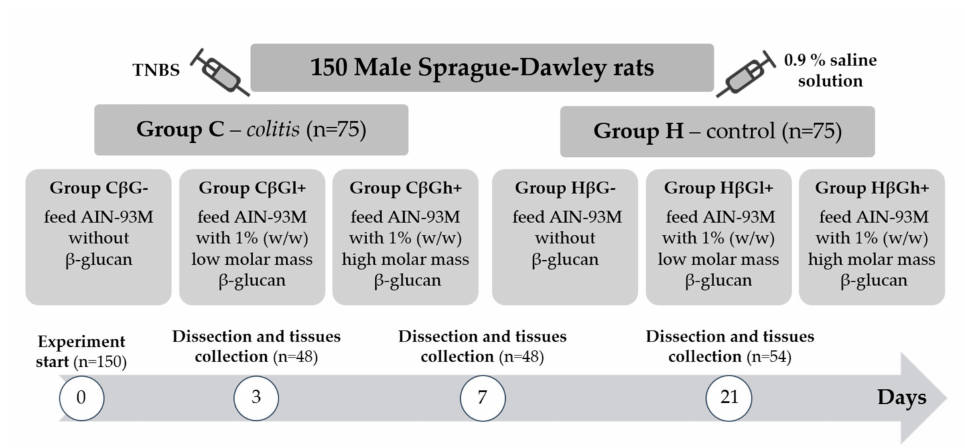
Figure 1. Scheme of experimental design of the study. TNBS: 2,4,6,-trinitrobenzenesulfonic acid alcohol